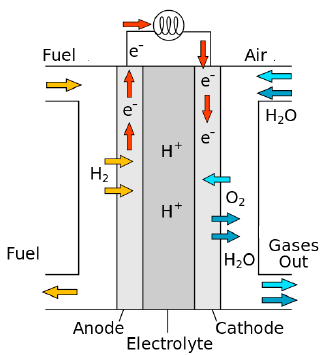
Figure 7. Typical Fuel Cell Operative Mode.